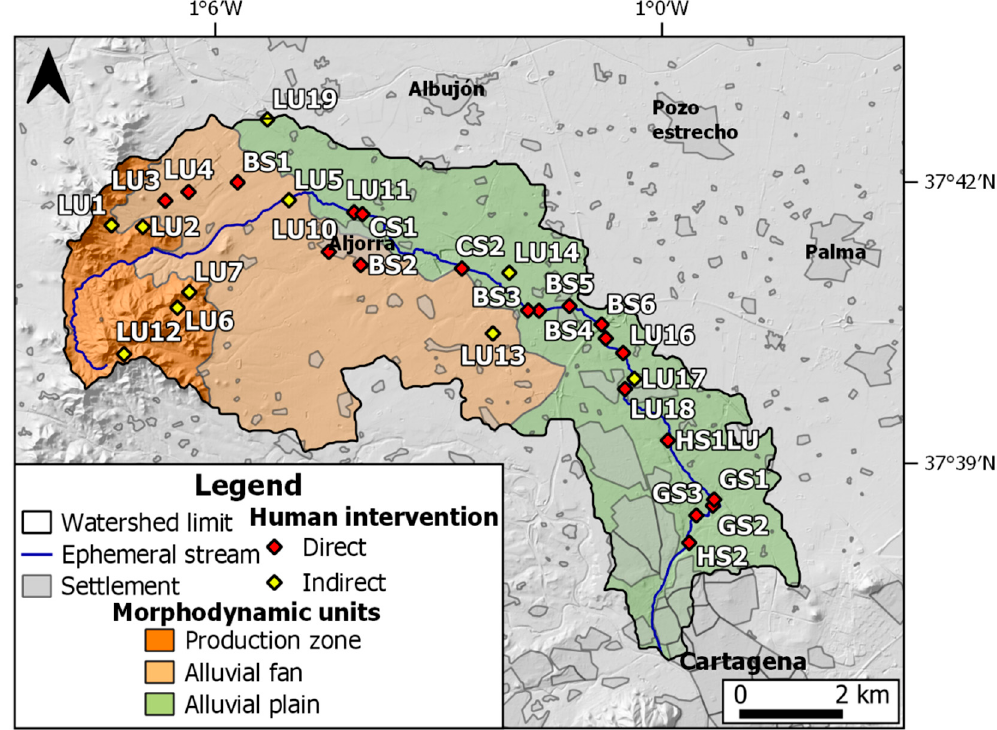
Figure 11. Human interventions in the Rebollos watershed.